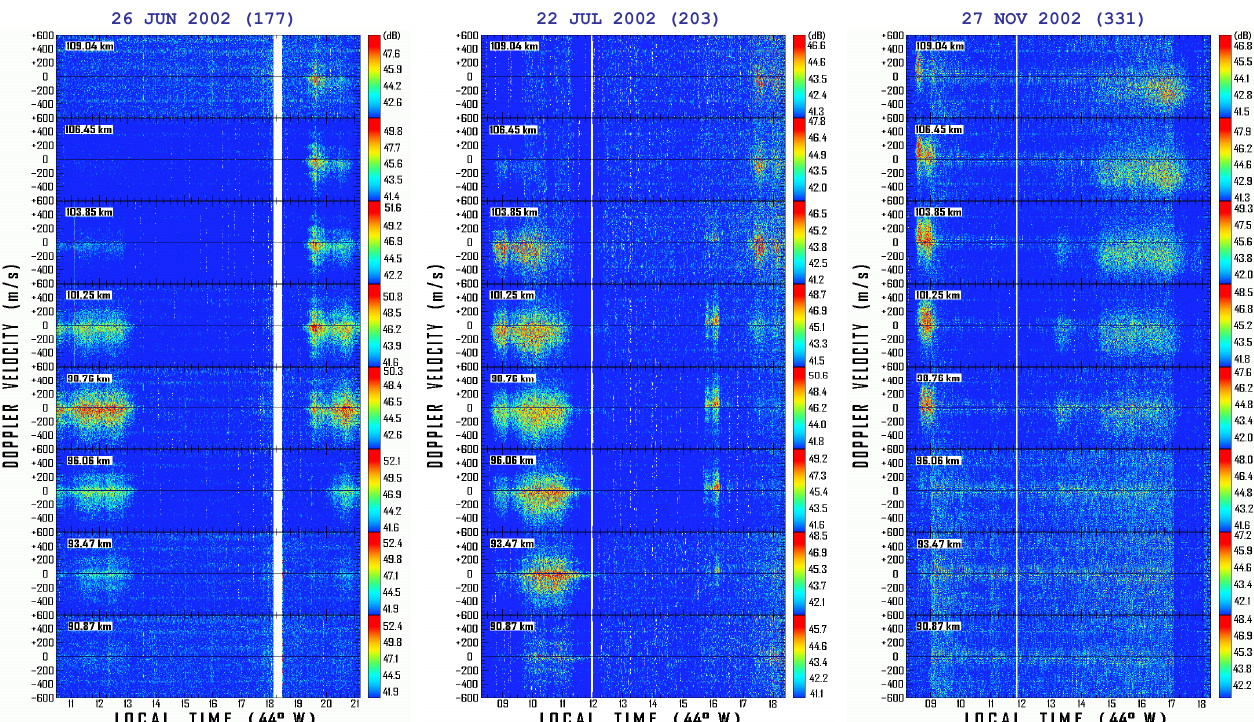
Figure 3. Set of eight spectrograms covering the range height from 90.9 to 109.0 km, obtained on (from the left) 26 June 2002, 22 July 2002 and 27 November 2002, when an evening, an afternoon and a morning CEJ events have been detected, respectively. The central height of each spectrogram, which covers 2.6 km of altitude, is informed on the top left corner of the corresponding spectrogram and the power scale on the right side is given in dB units.